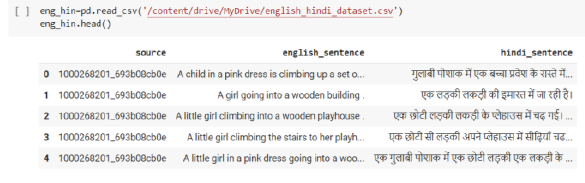
Fig. 4. English-Hindi Dataset